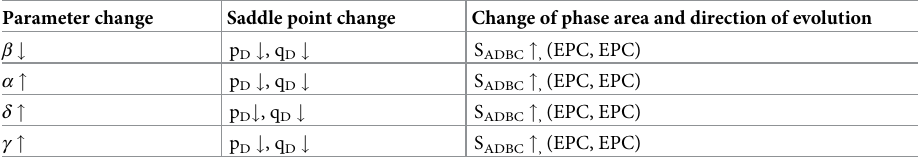
Table 5. The influence of parameter changes on evolutionary game